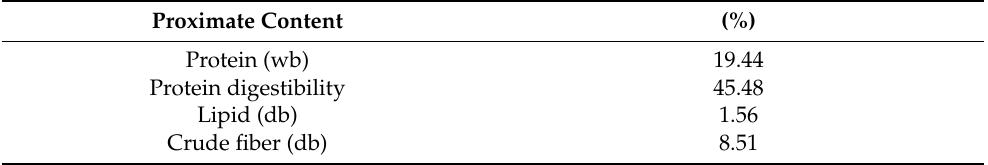
Table 2. Proximate content of fungal biomass Rhizopus oligosporus cultivated at pH four and an agita- tion speed of 125 rpm on residual water of tempeh processing with supplementation of yeast extract.